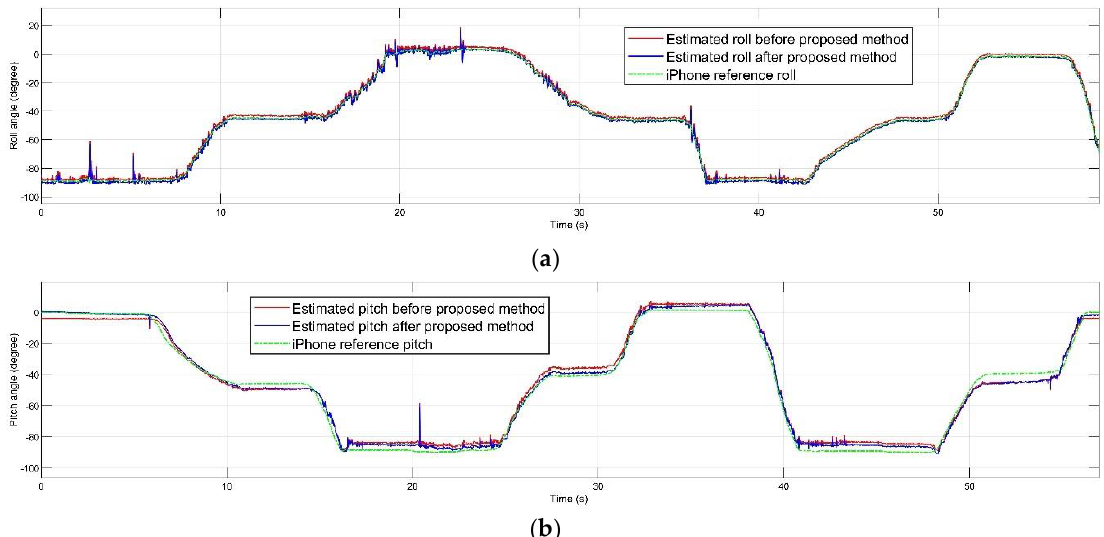
(c) Figure 3. Module MPU-9250 and smartphone iPhone 11 rotation trajectory for heading test: ( a ) 180 heading degree; ( b ) 135 heading degree; ( c ) 90 heading degree. Because of minimum RMSE for iPhone, this smartphone was chosen as the orientation reference of our experiments. All tests were done using data of IMU from MPU-9250, which, in this study, is referred to as “module.” The proposed EKF-based AHRS algorithm was implemented in MATLAB and estimated the final orientation of the module from the recorded data in various durations between 60 s to 100 s. The module was connected to the laptop with a USB cable, and the data of magnetometer, gyroscope, and accelerometer were recorded by the MATLAB-based serial reader. Also, data of iPhone’s IMU was recorded in the MATLAB cloud with the “MATLAB mobile” iOS application. The smartphone and module were located on the degree marked table at the same time, one time along the z axis, one time along the y axis, and finally, along the x axis. To obtain more accurate results, the trajectory for each experiment were selected in a way that allowed all angles to